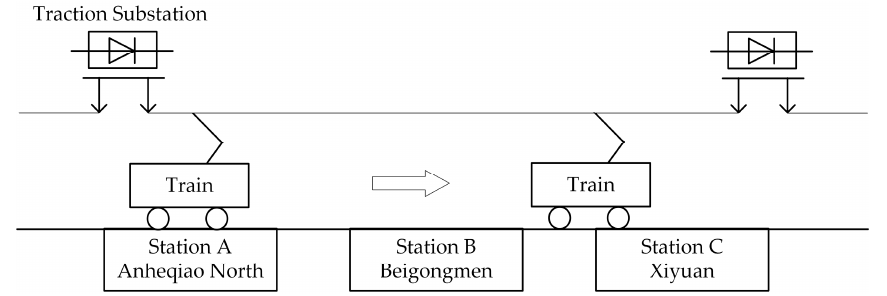
Figure 2. The structure of the traction substation system.